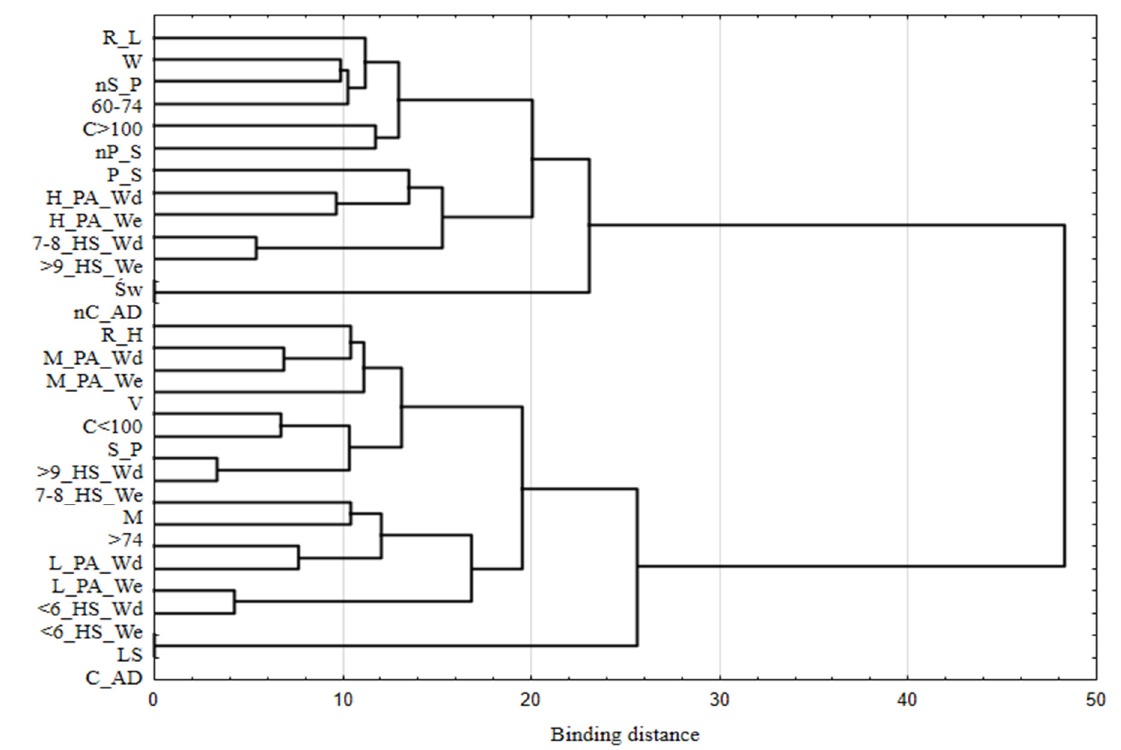
Figure 1. Hierarchical classification of variables describing nutritional risk, based on selected demographic and lifestyle features. R_L—low nutritional risk; R_H—high nutritional risk; W—